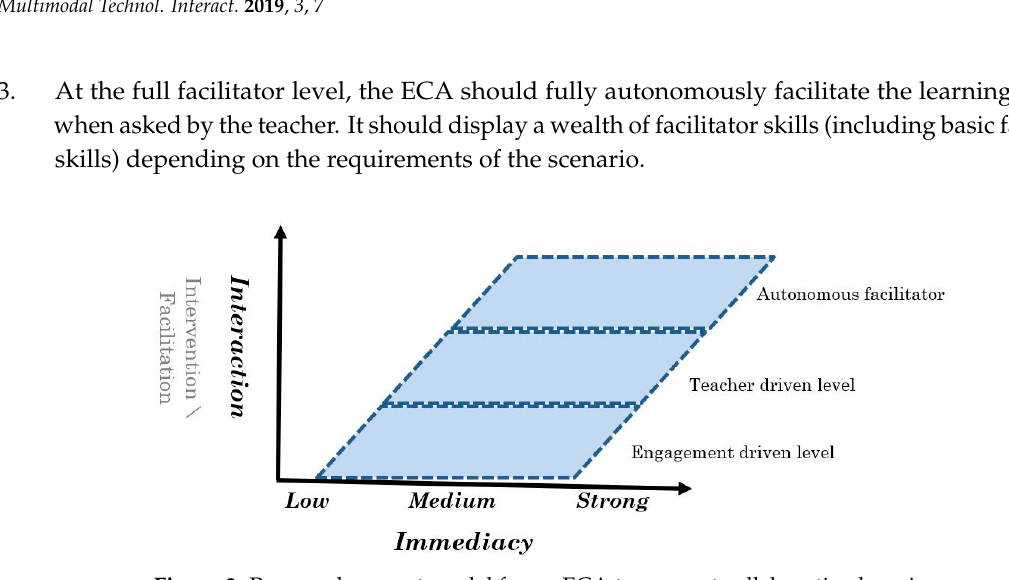
Figure 3. Proposed rapport model for an ECA to support collaborative learning.